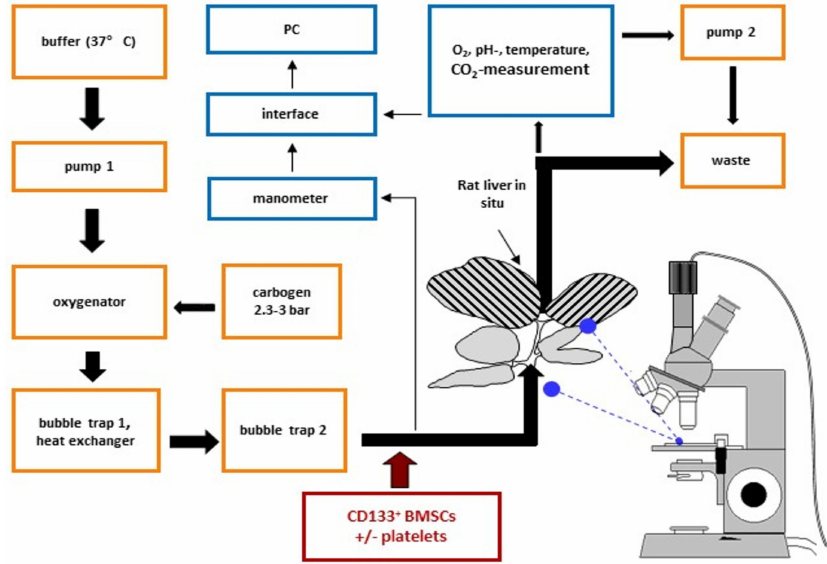
Figure 3. Ex vivo xenogeneic IPRL model with video-assisted in situ imaging. Direction of arrows indicates bu ff er and cell flow in the in situ system. The black shades stripes within the analyzed liver represent 70% hepatectomy. Portal vein of the rat liver was cannulated and left in situ and liver was drained via the cannulation of the vena cava